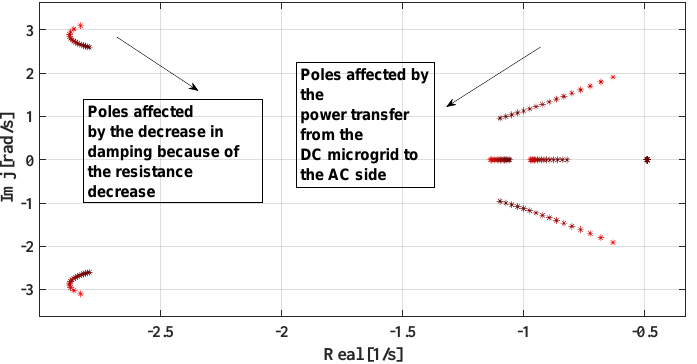
Figure 7. Eigenvalues with varying DC loading.